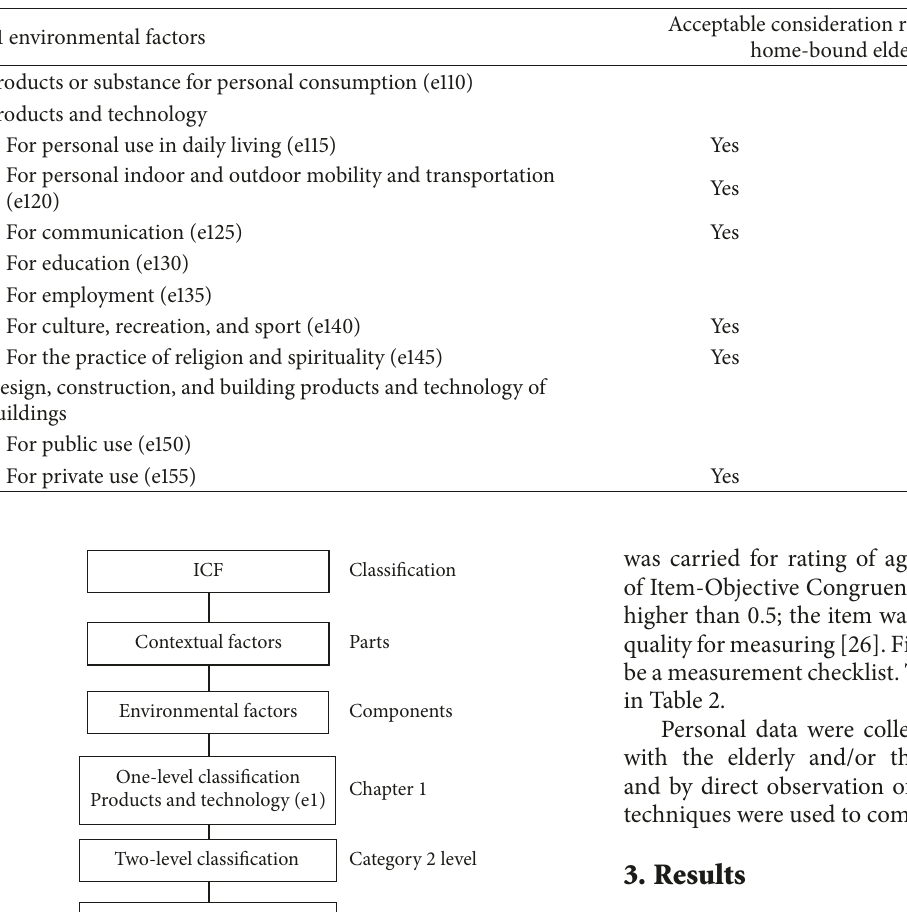
Table 2: Categories of the AT checklist under ICF.